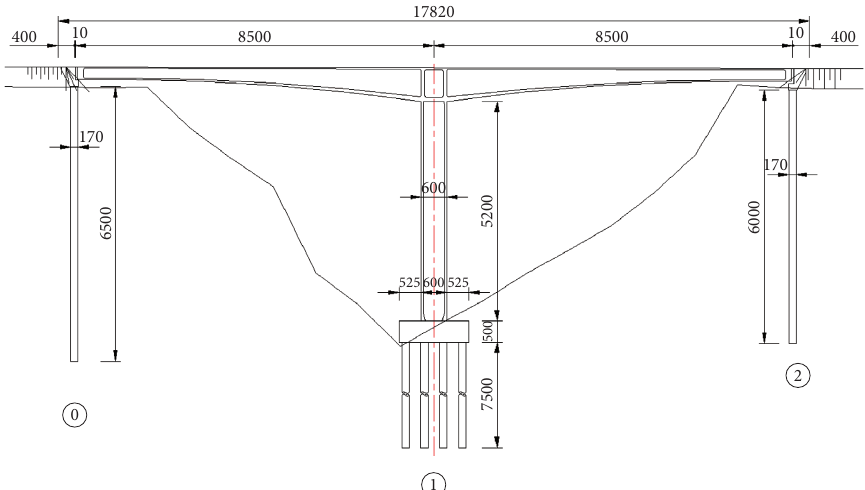
Figure 2: Elevation view of the T-shaped rigid frame bridge (all dimensions: cm).